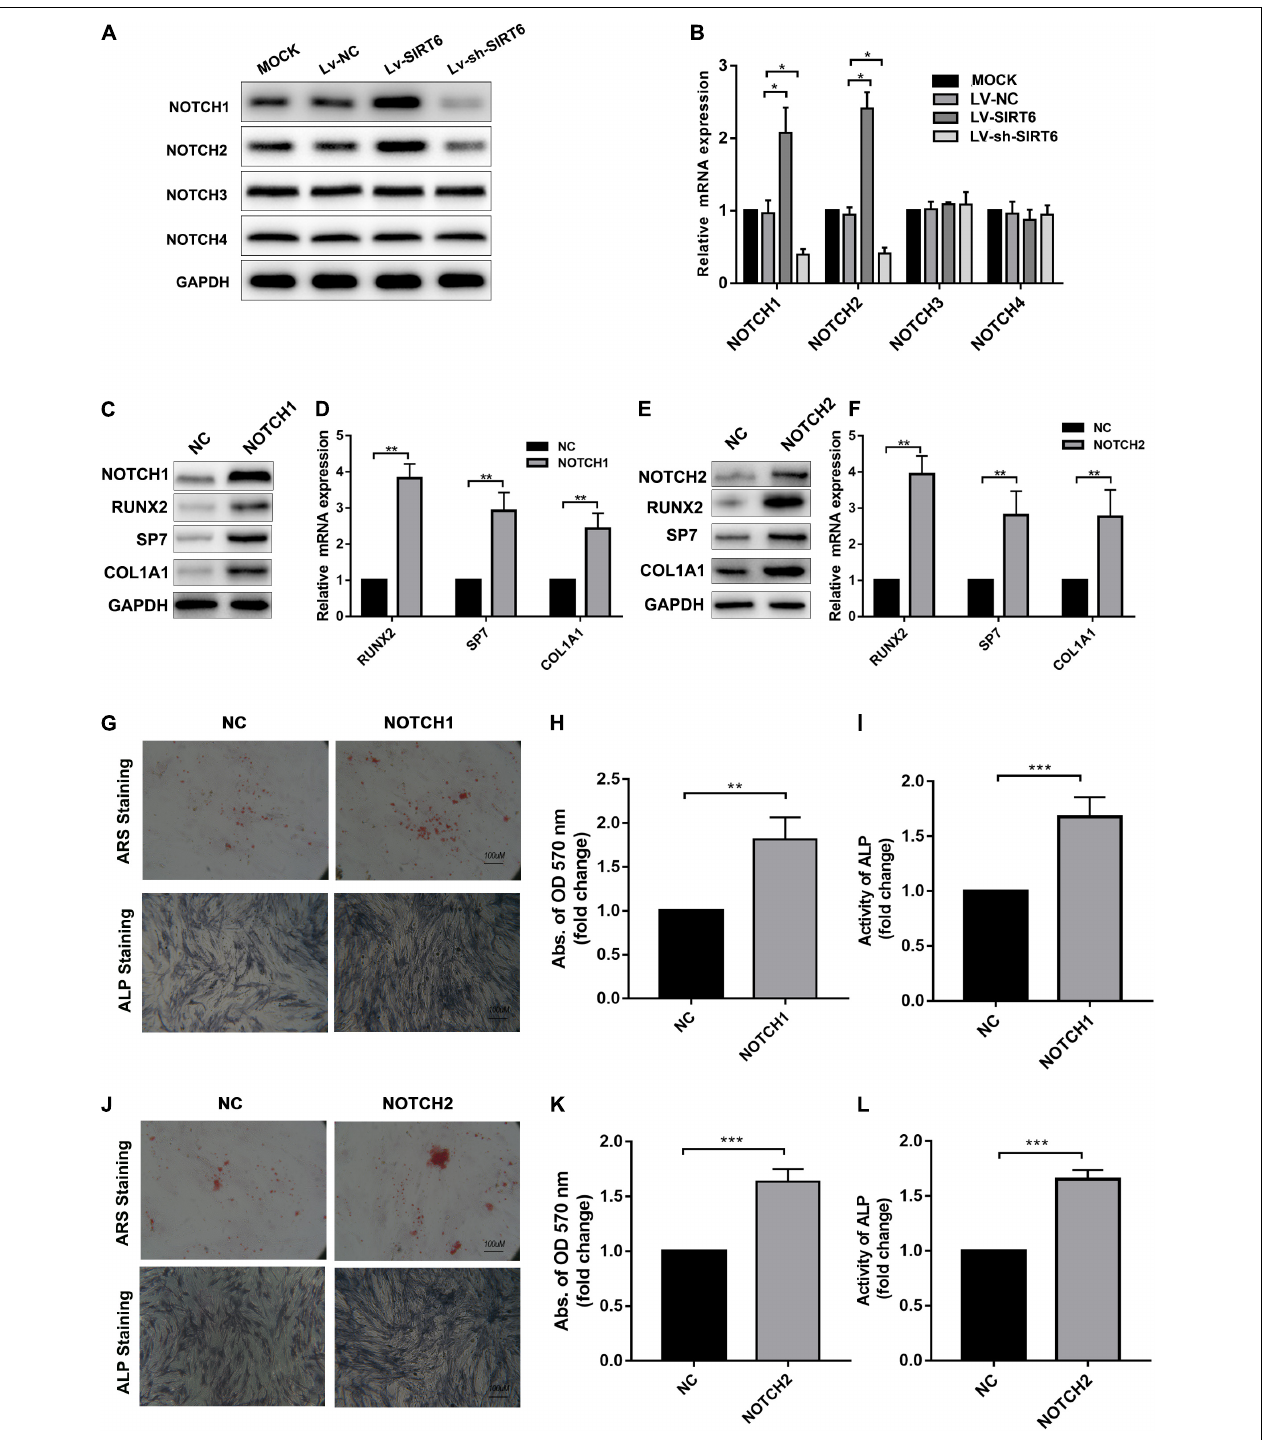
FIGURE 2 | (A,B) Western blot and RT-qPCR showed the expression of NOTCH1, NOTCH2 was increased by SIRT6 overexpression and decreased by SIRT6 knockdown. (C,D) High expression of NOTCH1, RUNX2, SP7 and COL1A1 in NOTCH1 overexpressed hADSCs, was determined by Western blot and RT-qPCR. (E,F) Expression of NOTCH1, RUNX2, SP7, and COL1A1 in NOTCH2 overexpressed hADSCs, determined by Western blot and RT-qPCR. (G–I) Images of Alizarin red staining and ALP staining in NOTCH1 overexpressed hADSCs. Histograms show ALP activity and quantification of Alizarin red staining by spectrophotometry. (J–L) Images of Alizarin red staining and ALP staining in NOTCH2 overexpressed hADSCs. Histograms show ALP activity and quantification of Alizarin red staining by spectrophotometry. Data were shown as mean ± SD. * p < 0.05, ** p < 0.01, *** p <